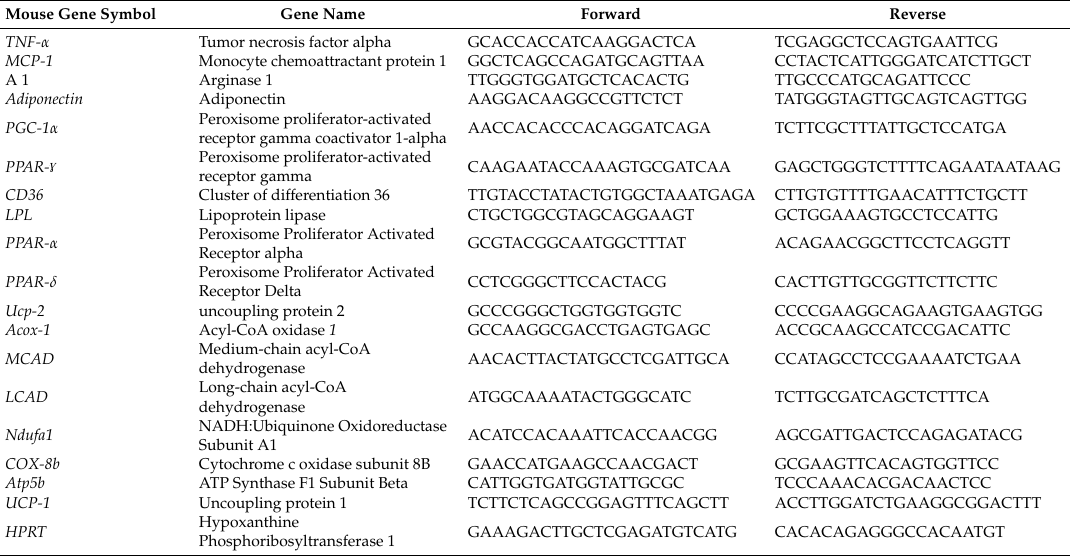
Table 1. Sequence of primers used for RT-PCR experiments.